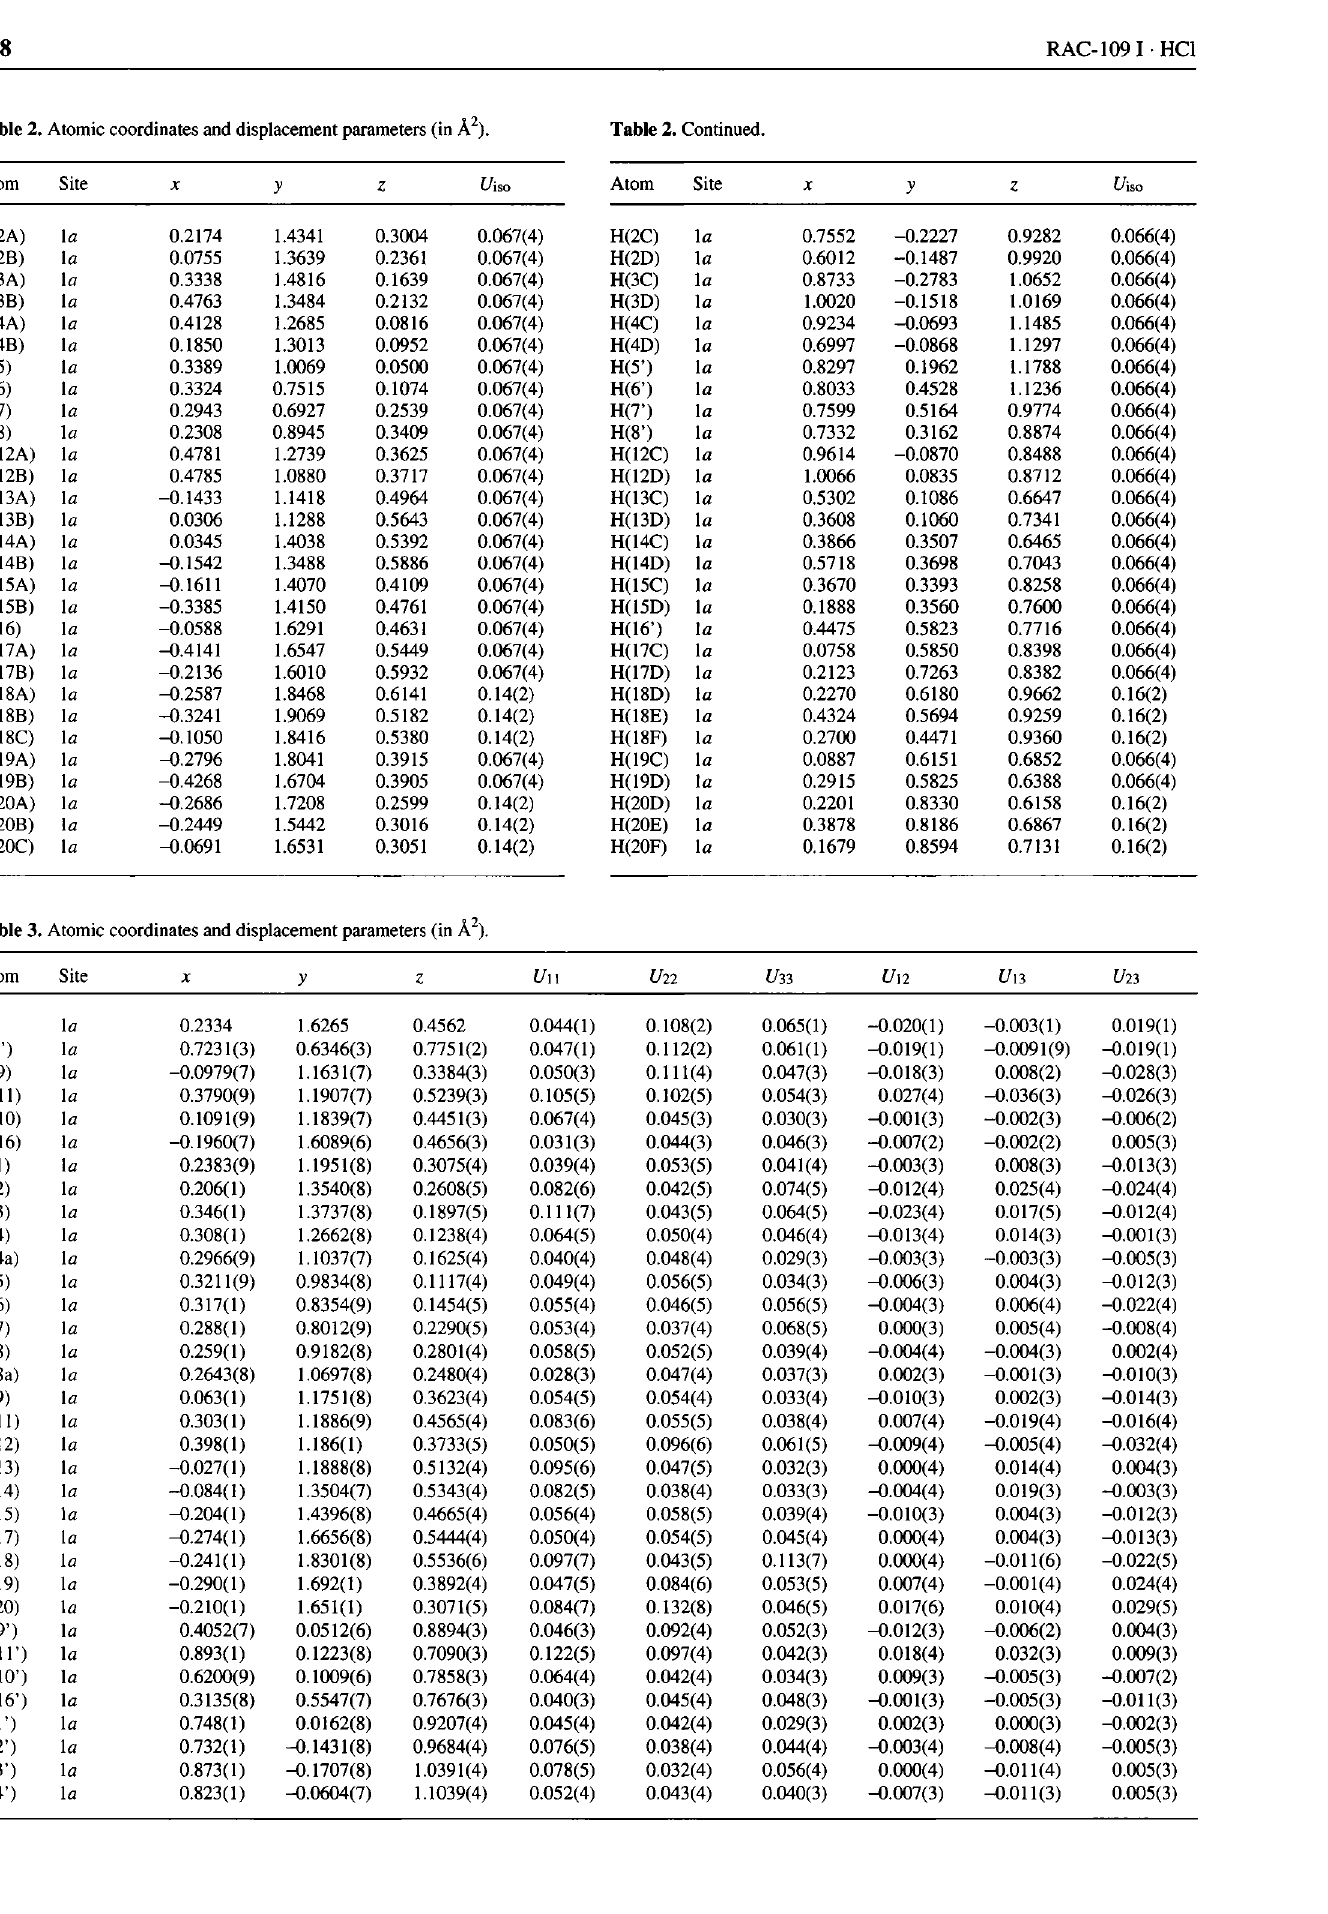
Table 2. Atomic coordinates and displacement parameters (in Ä 2 ).